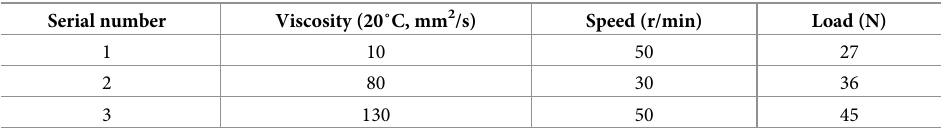
Table 4. Verification of three different working conditions.